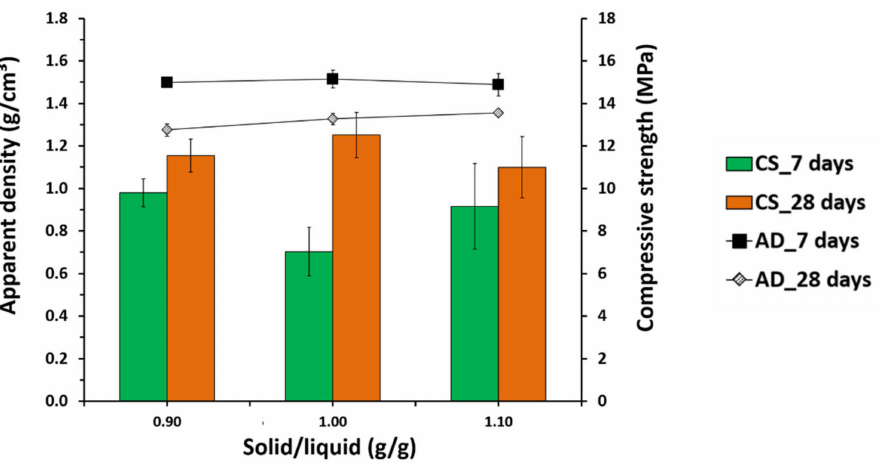
Figure 3. The apparent density and compressive strength of the alkali activated MK-binders at 7 and 28 days of curing as a function of the solid-to-liquid mass